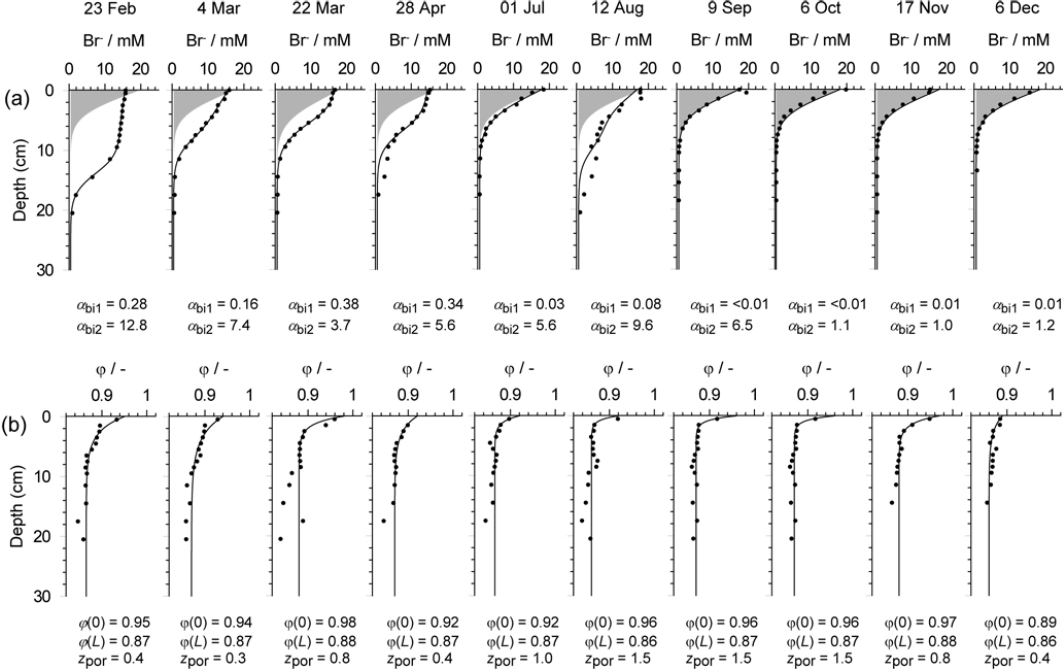
Fig. 3. (a) Bromide tracer concentrations (symbols) measured in cores incubated for bioirrigation experiments sampled on the day in 2010 shown on the top of the figure. The curve represents the modeled tracer concentration at the end of the incubation period using the pa- rameters indicated (Eq. 2), and the shaded interval shows the expected bromide profile assuming transport by molecular diffusion only. For each model run, the modeled porosity curves shown in (b) were used, defined by the parameters given in each panel and the equation ϕ = ϕ ( L ) + ( ϕ (0) − ϕ ( L ))exp( − z / z por ) (see